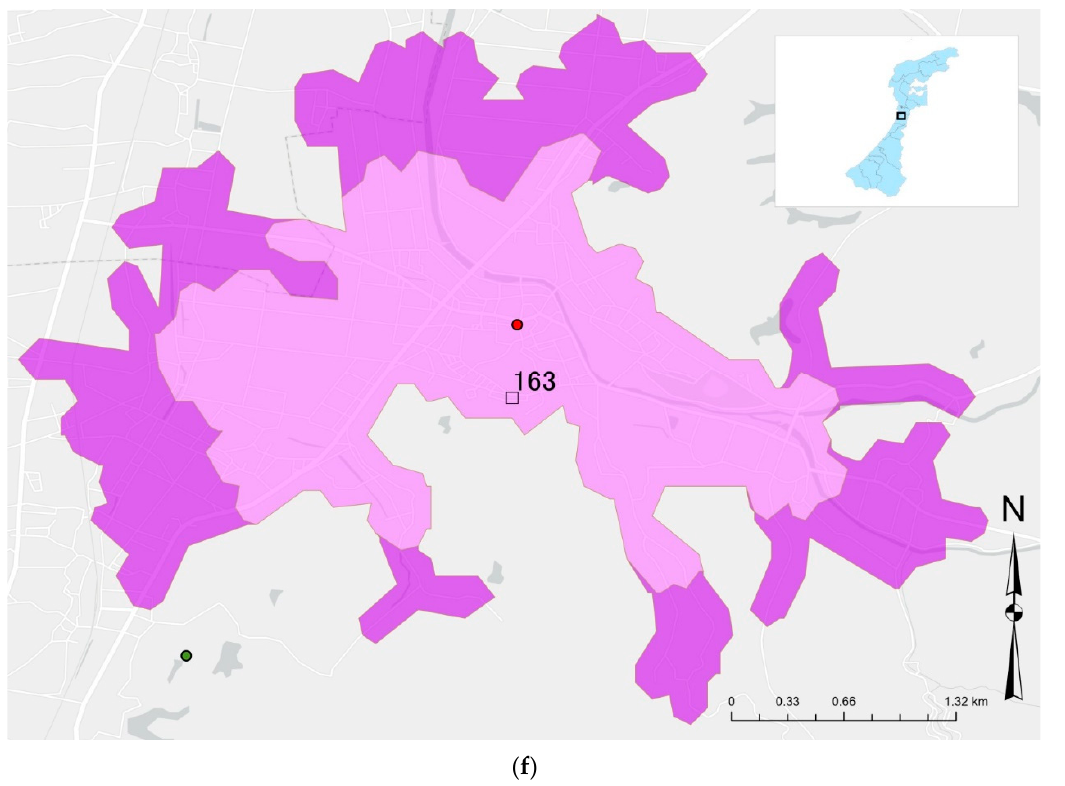
Figure 8. ( a ) GH with only one SP in its ELA for adults. ( b ) GH with only one SP in its ELA for older adults (For legends, see Figure 8a). ( c ) GH with only one SP in its ELA for older adults (For legends, see Figure 8a). ( d ) GH with only one SP in its ELA for older adults (For legends, see Figure 8a). ( e ) GH with only one SP in its ELA for older adults (For legends, see Figure 8a). ( f ) GH with only